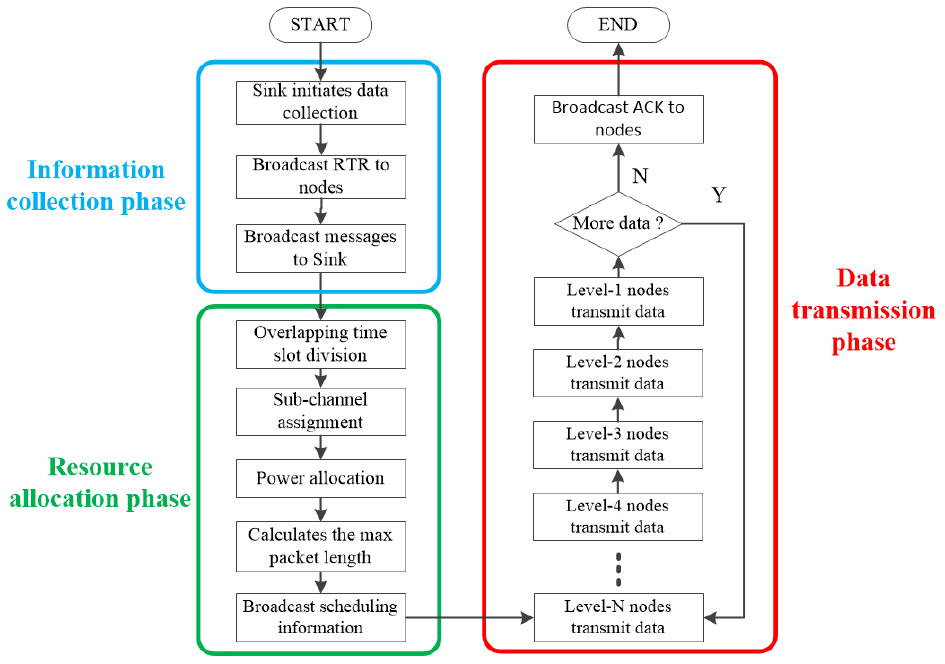
Figure 2. Flowchart of